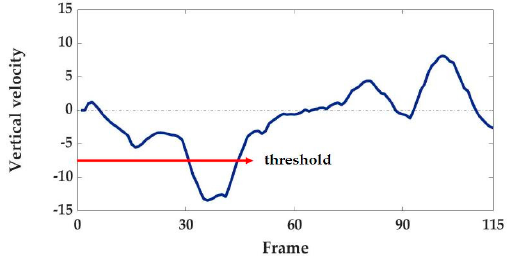
Figure 8. Vertical velocity and the corresponding threshold used to detect the start of the potential fall state.